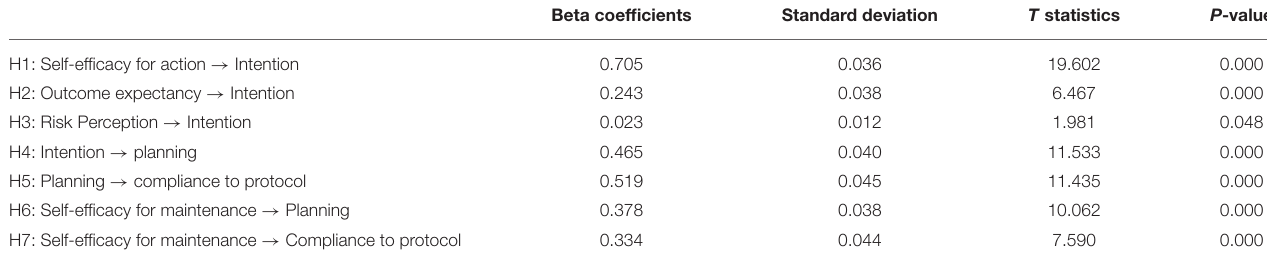
TABLE 8 | Result of final model